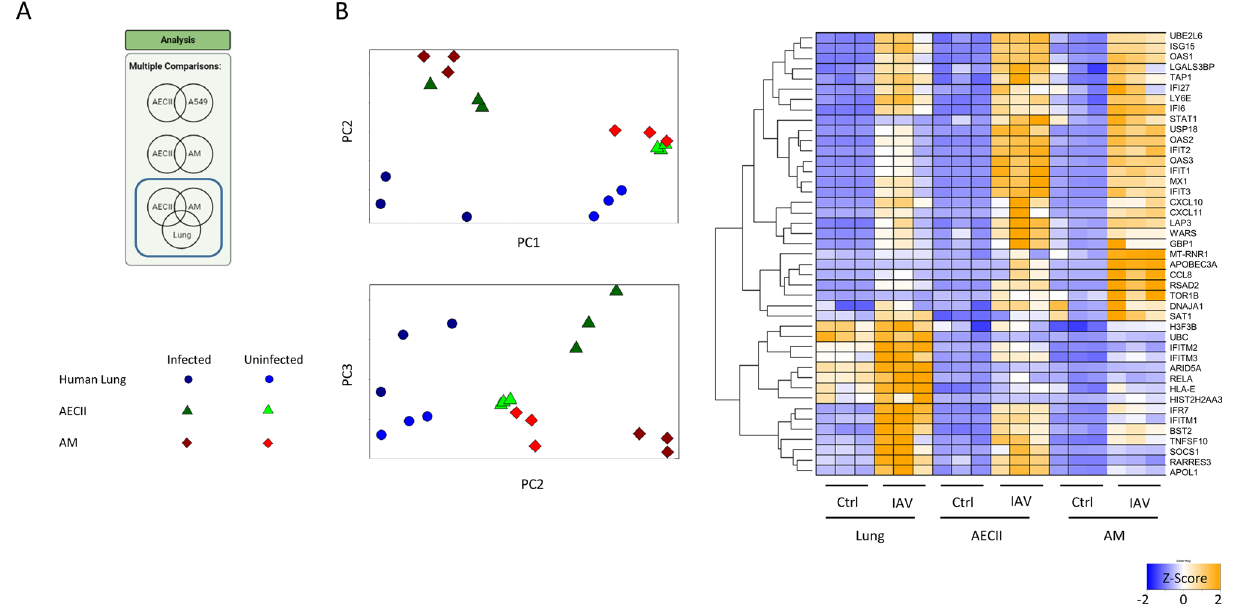
Figure 3. Infection with IAV leads to a broad transcriptional response in primary human cells and in whole lung tissue. ( A ) A set of 302 induced genes is shared as a common response between all cell types (a core set of genes), but the expression level of these genes differs across cell types. Principal component analysis (PCA) was performed to resolve the contribution of individual genes from this core signature to the different transcriptional landscapes. PC1 separated control samples from infected samples, PC2 separated AECII from human lung samples, and PC3 separated AECII from AM. Z-scores of genes driving sample separation were calculated on the basis of transcripts per million (TPM) and are shown as a heatmap ( B ). Parts of this Figure were made with Biorender.